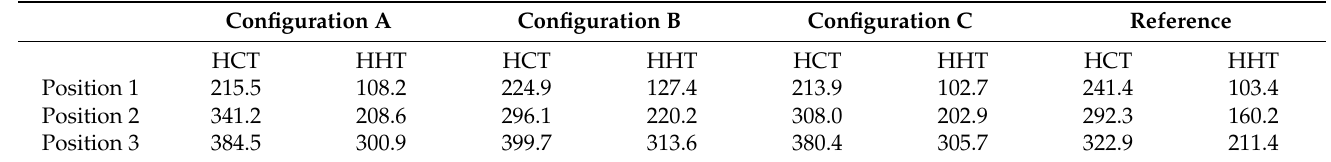
Table 2. Results of HCT and HHT of the various packages